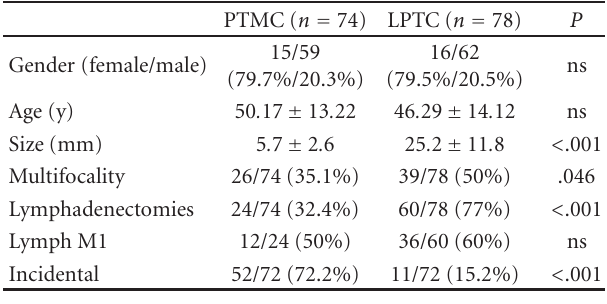
Table 1: Di ff erences between cases with papillary thyroid microcar- cinomas (PTMCs) from those with papillary thyroid carcinomas of larger size (LPTCs).